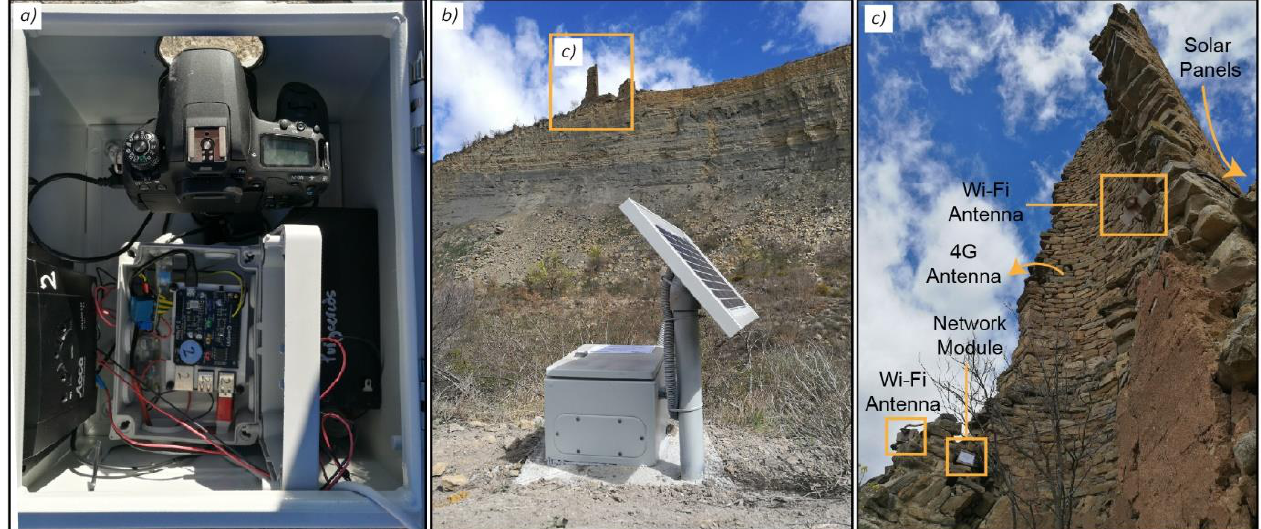
Figure 2. Components of the photogrammetric system mounted at Puigcercós. ( a ) Internal view of the camera module composed of a Canon 77D camera and the auxiliary control system. ( b ) External view of a camera module in front of the Puigcercós cliff. ( c ) Installation site of the 4G data transmission module on the upper part of the rock cliff. The two sectorial Wi-Fi antennas, the router module and the battery can be seen in the tower.